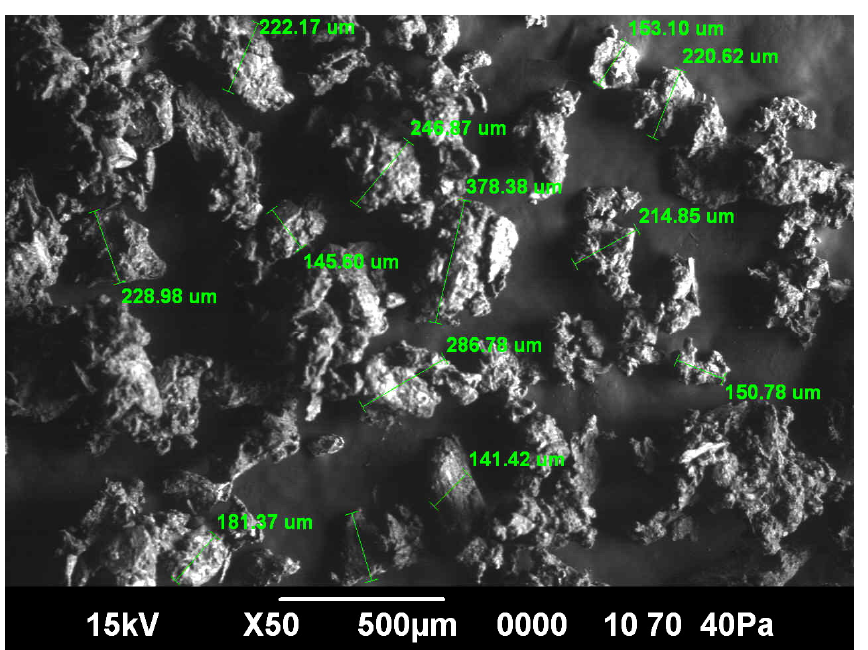
Figure 2. Bone particle sizes of meat-bone paste.